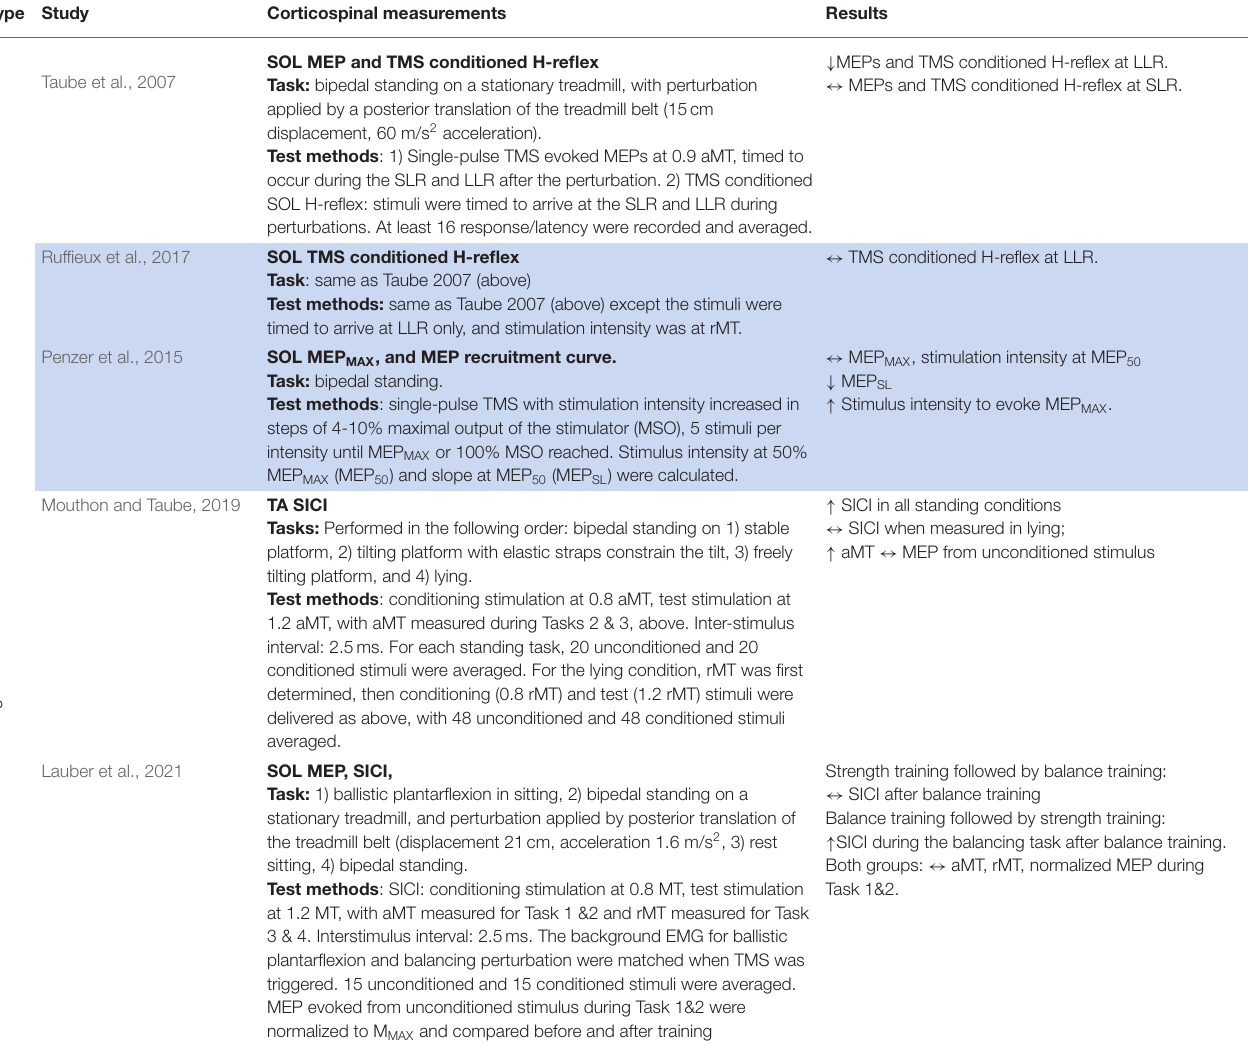
TABLE 4 | Corticospinal and intracortical excitability - measurements and